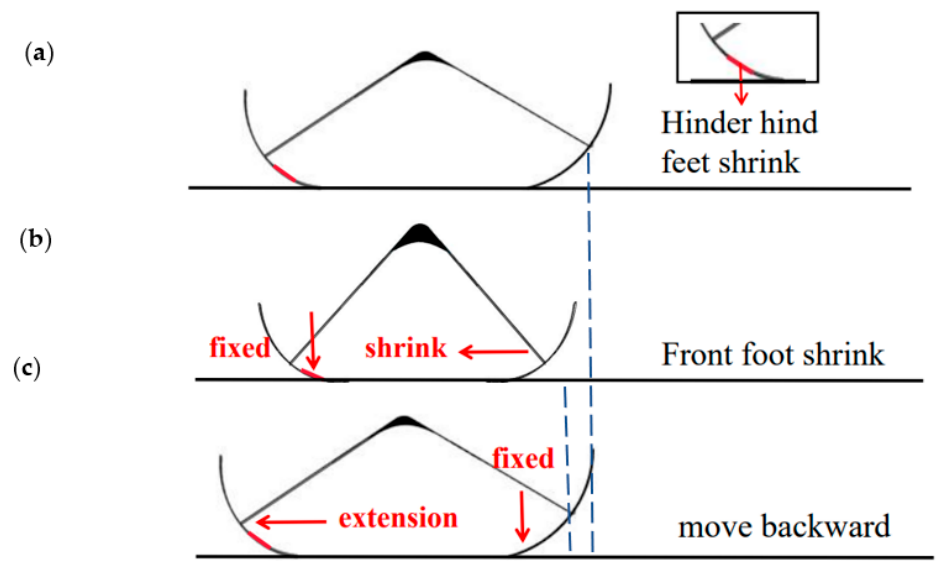
Figure 6. Backward running principle. Positioning the front foot of the robot with a blue dotted line indicates that the robot is moving backward. ( a ) Power on state, hind foot fixed; ( b ) Power off state, front foot shrinks; ( c ) Power on state, front foot fixed, hind foot extension, robot moves backward.